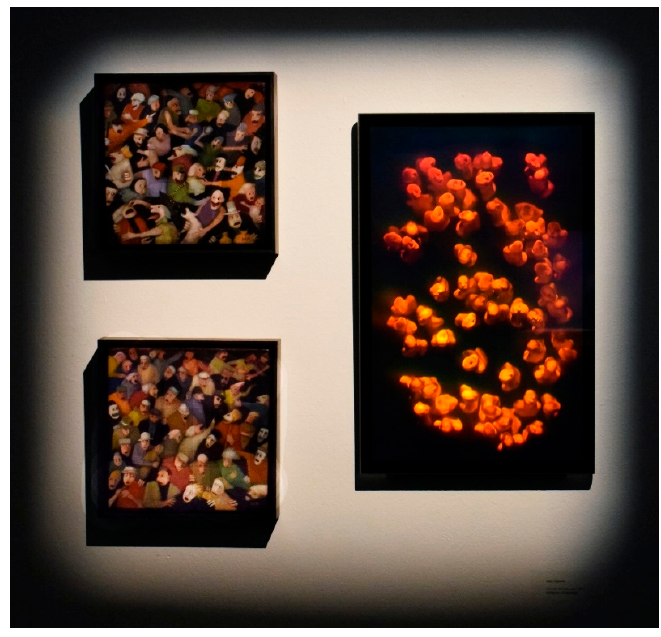
Figure 9. Installation view, “Currents New Media” (2017), Santa Fe, New Mexico. Left: Civil Discourse (2016–17), two acrylic paintings on wood panels each 25 cm × 25 cm. Right: Lost Souls (2017), Dichromate Gel (DCG) hologram, 46 cm × 30.5 cm × 5 cm. Photo used with permission of The Light Foundry, Santa Fe, N.M.